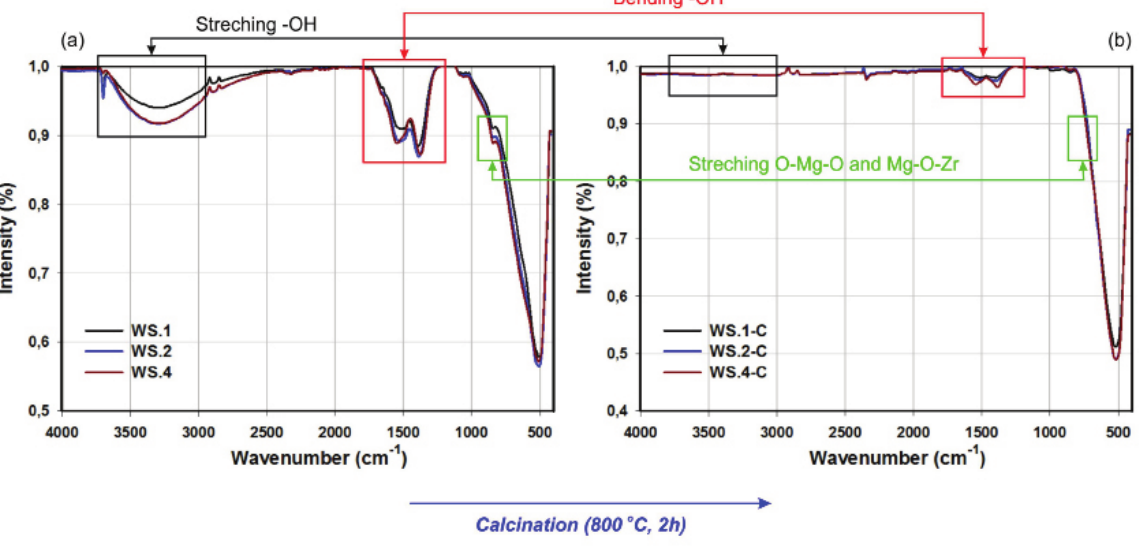
oxide materials: (a) uncalcined and (b) calcined at 800 ºC for 2 h. 2